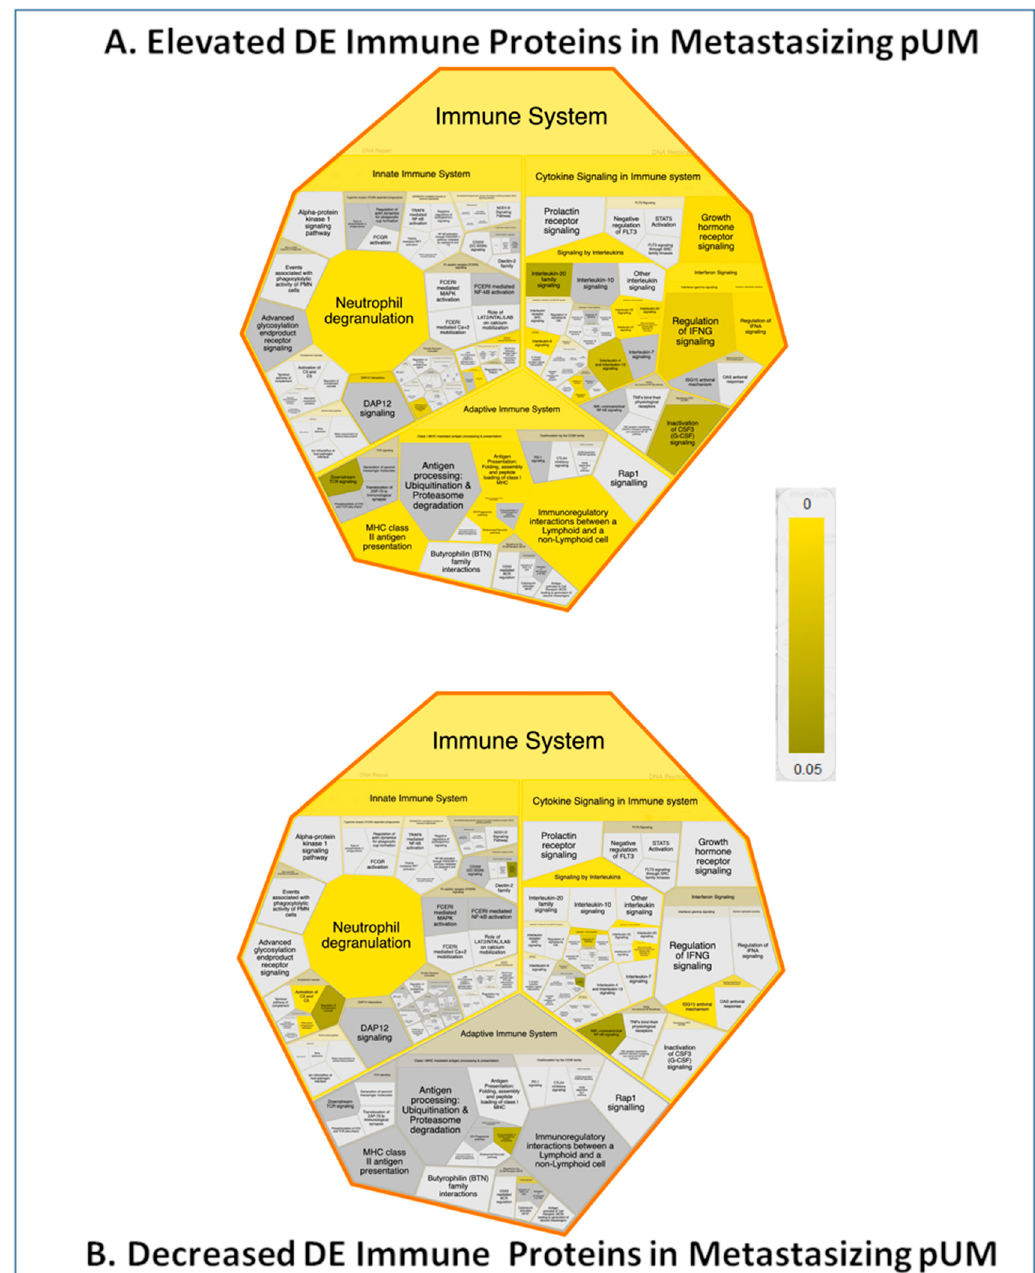
Figure 5. Immune System Pathways Associated with DE Immune Proteins. Reactome pathway analysis results are illustrated by Voronoi view for DE immune proteins elevated in metastasizing pUM ( n = 83, Panel A) and for those elevated in non-metastasizing pUM ( n = 60, panel B). Increased pathway over-representations are reflected by brighter colors. See Supplementary Tables S11 and S12 for details.